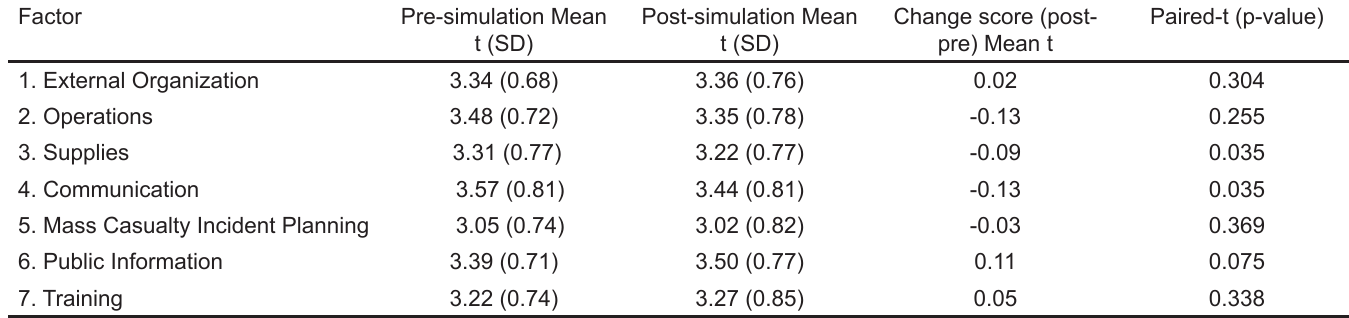
Table 3. Pre- and post-course preparedness ratings for 7 key factors in pandemic influenza training,using a Likert scale,